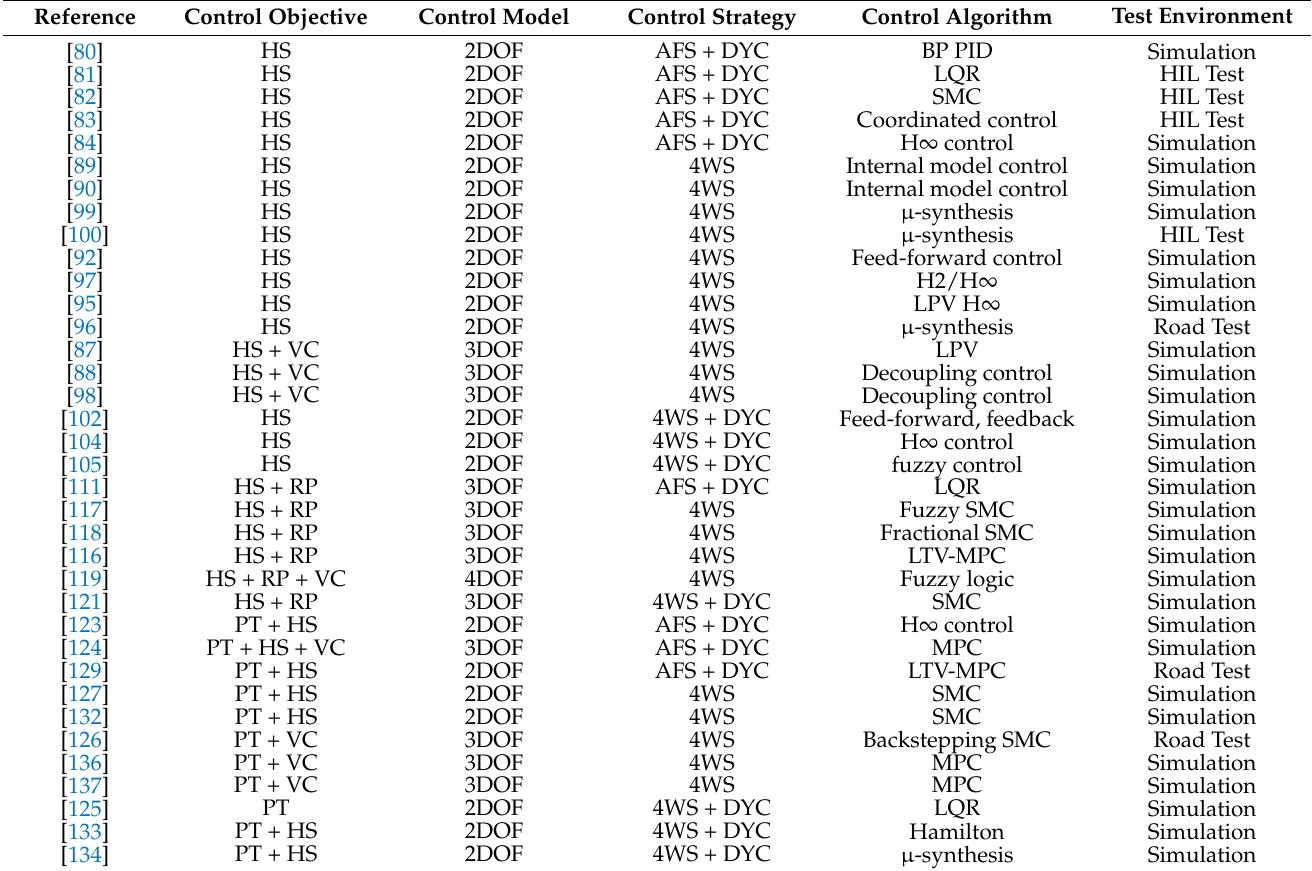
Table 4. Summary of various control